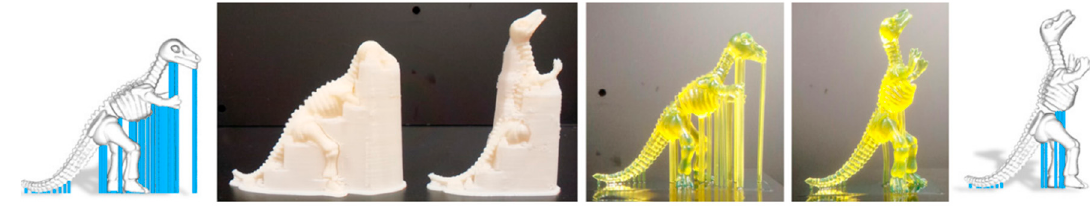
Figure 6. Examples for reducing support waste by deforming original shape [100].